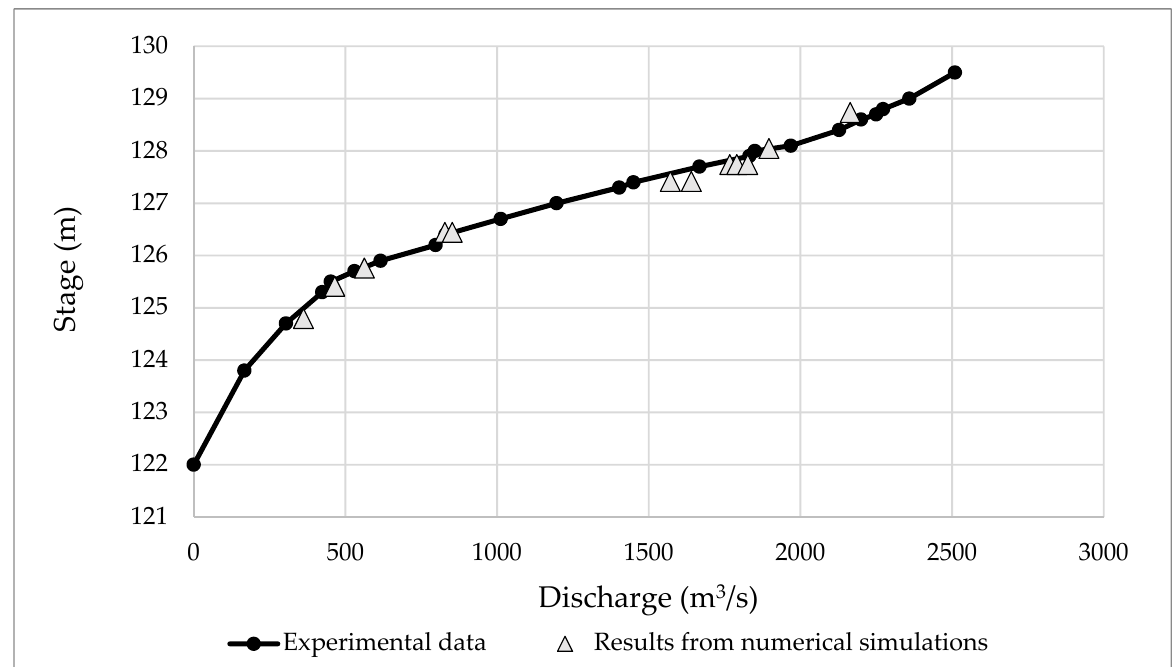
Figure 13. Rating curve from numerical simulations (Model #1) and experiments.